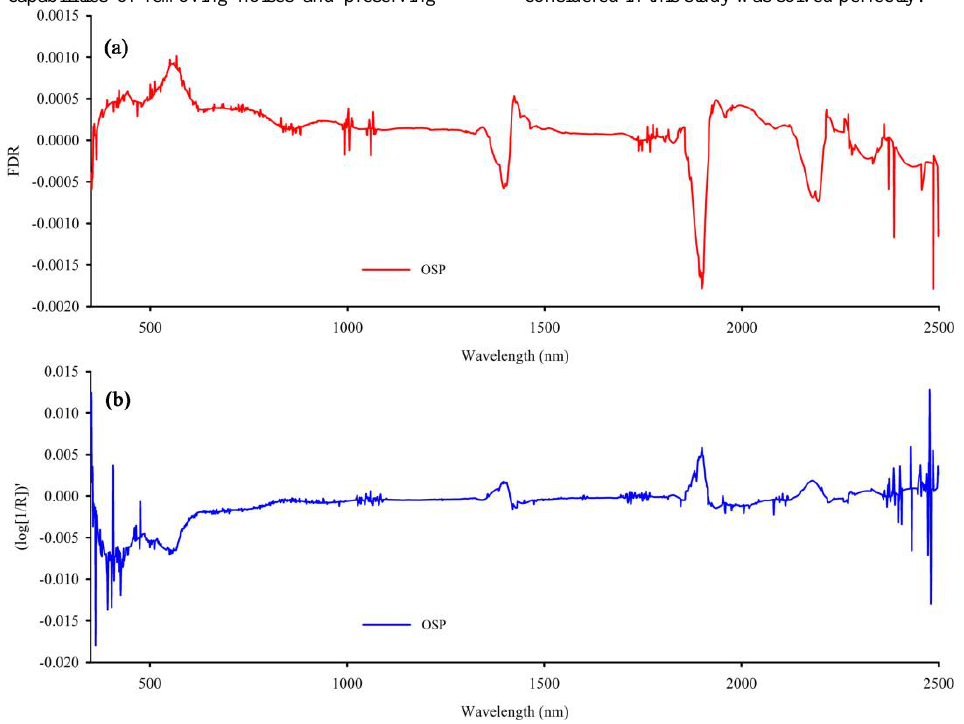
Table 2. Comparisons of the optimal correlative curve (OCC) of the first derivative differential (FDR) and the first derivative differential of reciprocal logarithm (log[1/R])'.